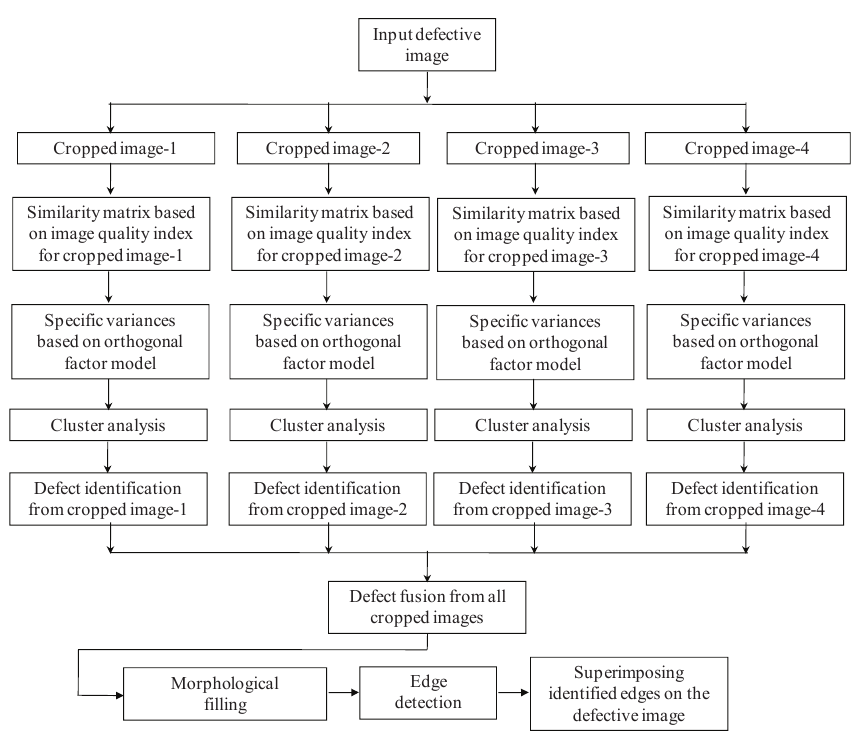
Figure 9. Defect detection scheme based on universal quality